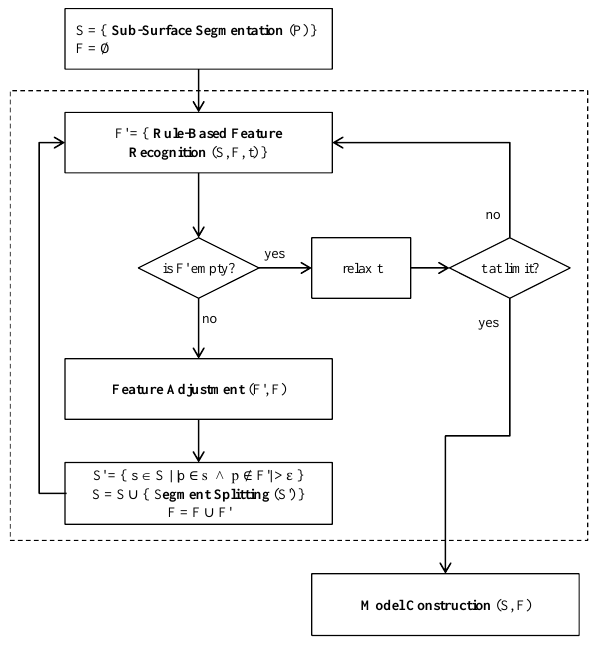
Figure 3. The feature recognition step in the context of the 3D building reconstruction approach (P = set of input points, S = set of segments, F = set of features, t = thresholds for feature